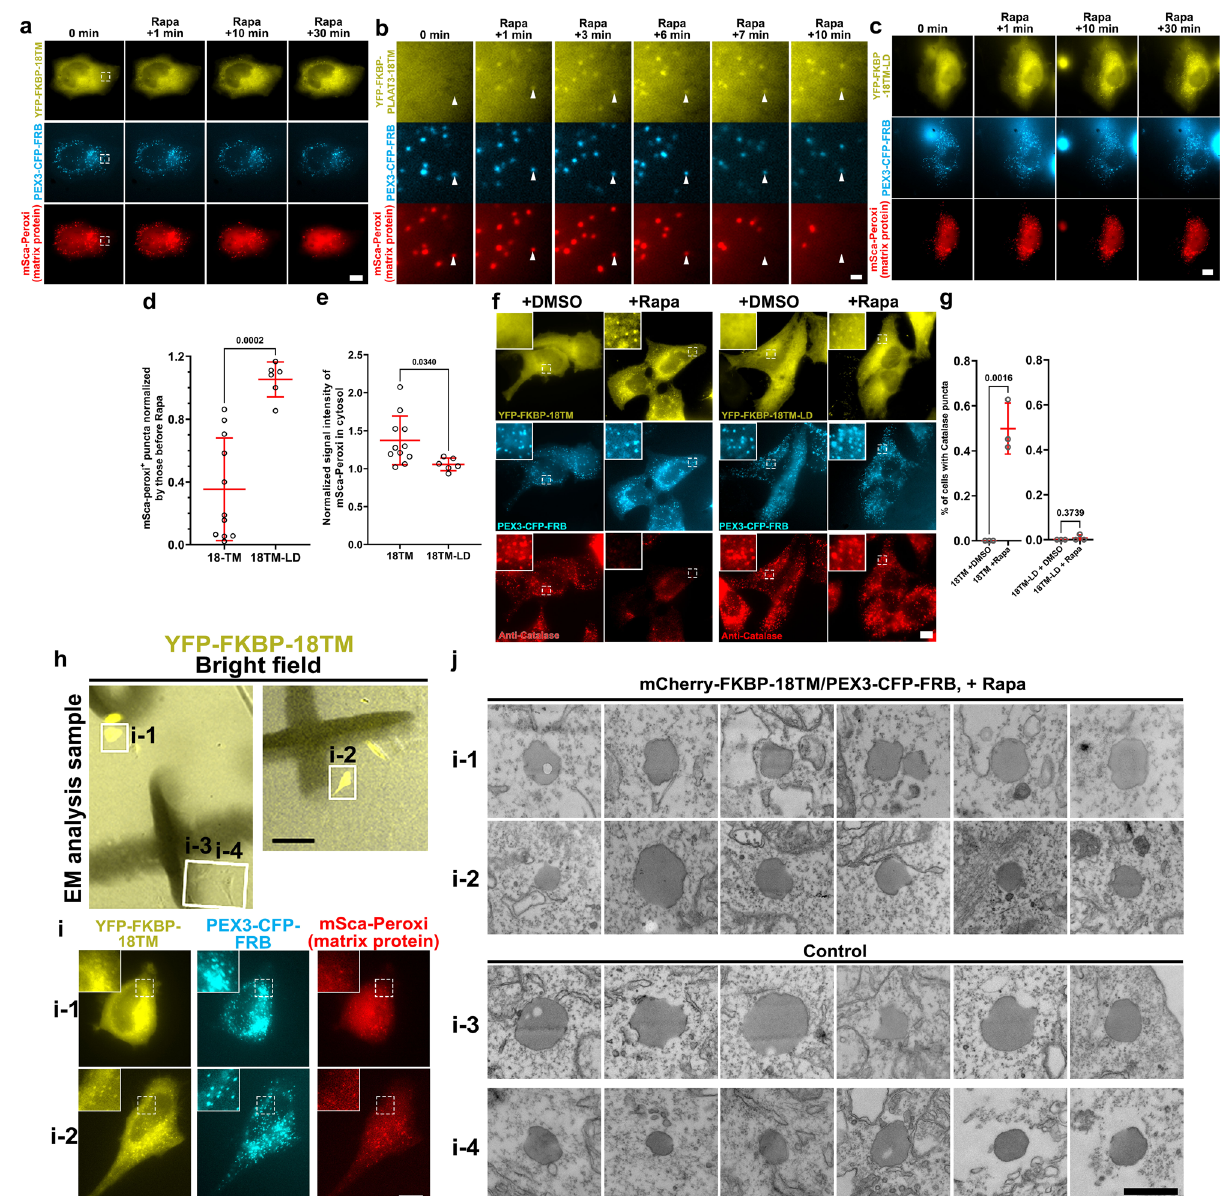
Fig. 6 | Rapid peroxisome defunctionalization by a chemically inducible PLAAT3-18TM. a – c Time-lapse fl uorescence images of peroxisomal luminal proteins (mSca-Peroxi) in HeLa cells are presented upon addition of 100nM rapamycin to trigger chemically induced recruitment of PLAAT3-18TM ( a ) or PLAAT3-18TM-LD( b ).Imagesindicatedbydottedwhitesquaresaremagni fi edin c . d Quanti fi cation of the fraction of mSca-peroxi + puncta ( n =11 for 18TM